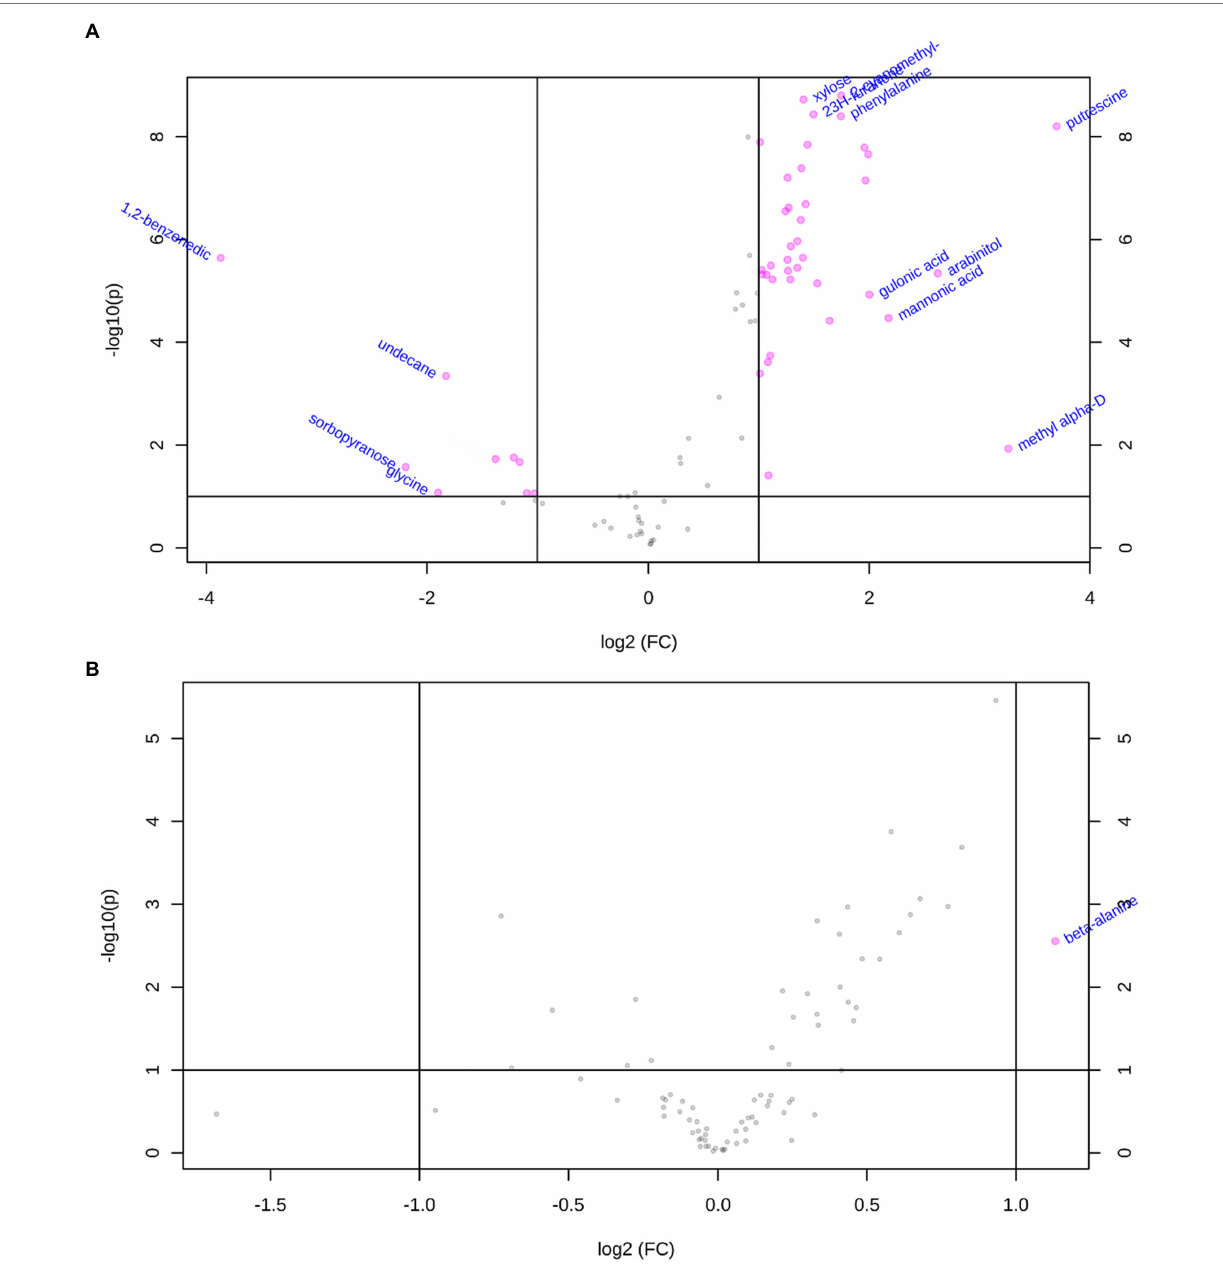
FIGURE 3 | Change of metabolome profile of tobacco in response to R. pseudosolanacearum infection. (A) Volcano plot showing differentially expressed (DE) metabolites and their value of p (p) in susceptible tobacco in response to R. pseudosolanacearum invasion. (B) Volcano plot showing differentially expressed (DE) metabolites and their value of p (p) in resistant tobacco in response to R. pseudosolanacearum